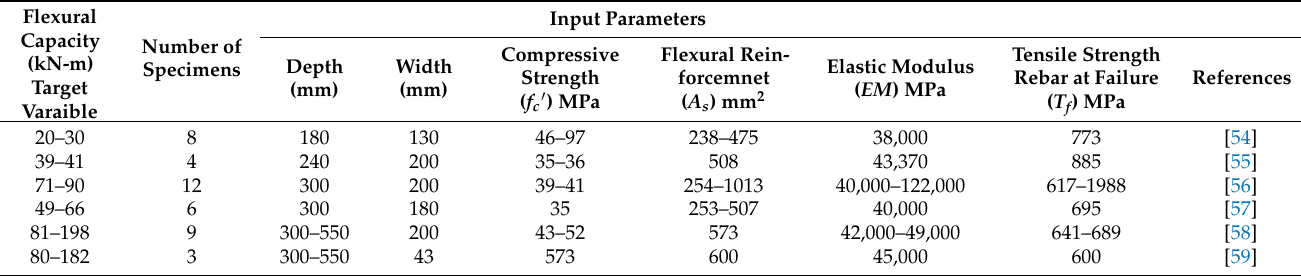
Table 1. Details of input and output parameters used in development of the